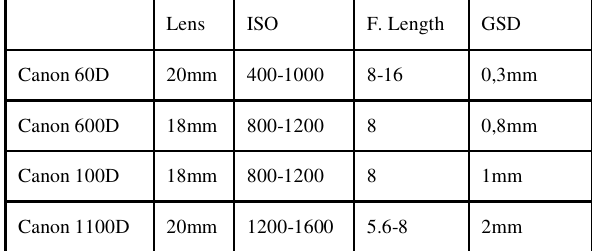
Table 1. The settings of the different cameras used for the photogrammetric survey